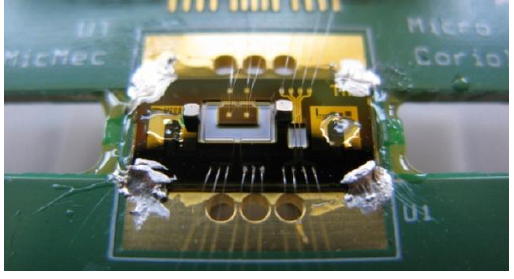
Figure 7. Single chip flow sensing system, mounted on a printed circuit